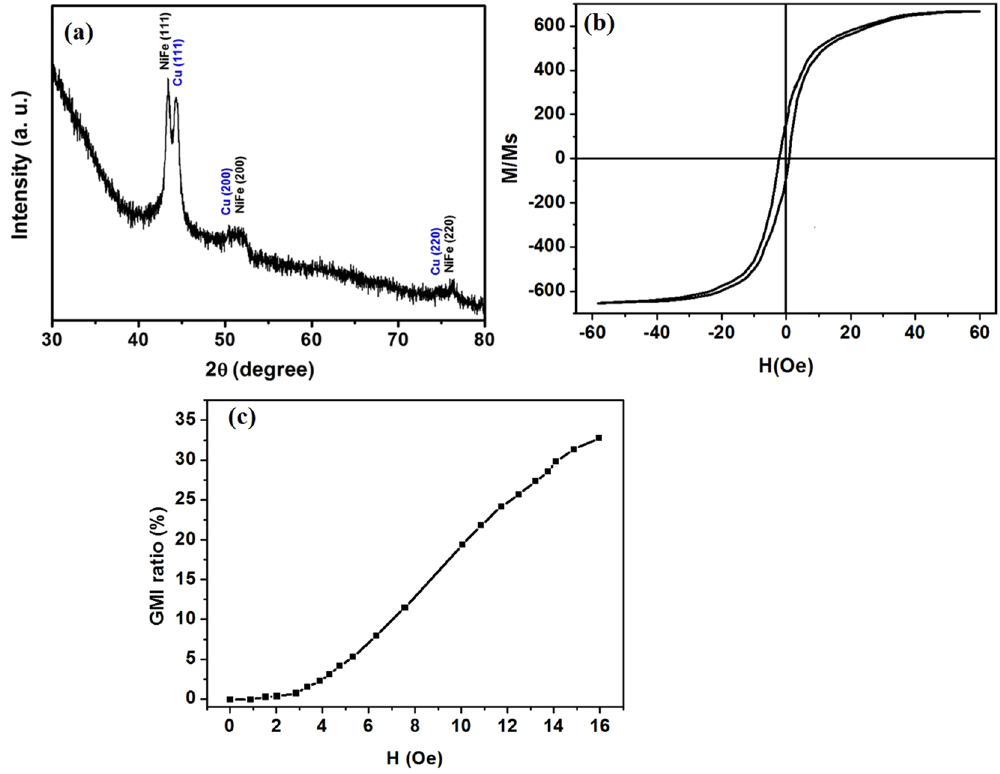
Figure 5. ( a ) X-ray diffraction pattern of the fabricated GMI magnetic sensor, ( b ) B-H curve of the GMI sensor, ( c ) Variation of GMI as a function of magnetic